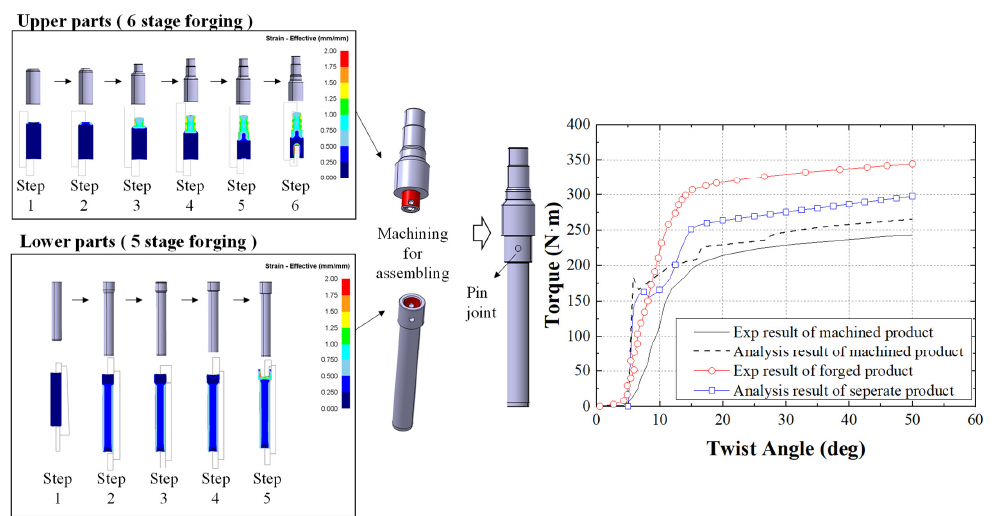
Figure 14. Numerical analysis of the separate input shaft process and the comparison of torque–angle curves obtained from numerical and experimental torsion test.